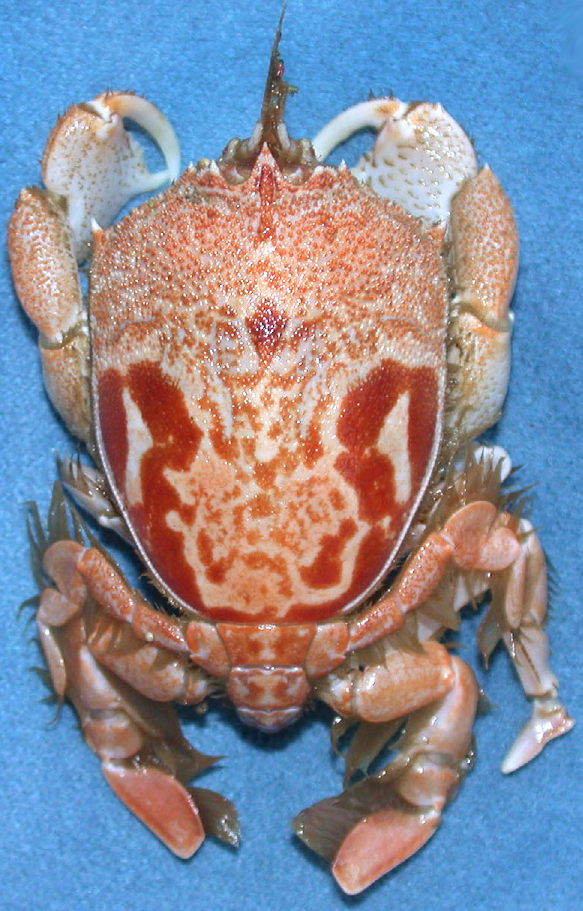
Figure 7. Color in life. Umalia misakiensis , male (16.0 x 21.8 mm) (ZRC 2001.0637),